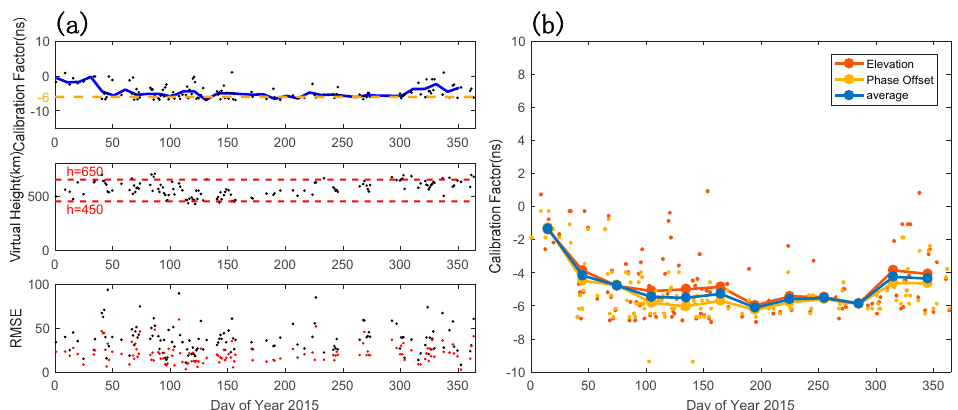
Figure 9. ( a ) The estimated calibration factor ( top ), mean virtual height ( middle ), and RMSE com- parison before and after calibration ( bottom ), from the Zhongshan radar in 2015. The yellow dotted line on the top panel represents a calibration factor of − 6 ns and the blue line represents the mean value from 10 days. The red dotted line in the middle panel represents a virtual height of 450 km and 650 km. ( b ) Statistical distribution of the calibration factors for the two methods in 2015, elevation angle ( red ), phase offset ( yellow ), and average of two ( blue ). Dots represent daily distributions, filled circles represent monthly distributions, and line graphs represent monthly averages calculated from the daily estimates.